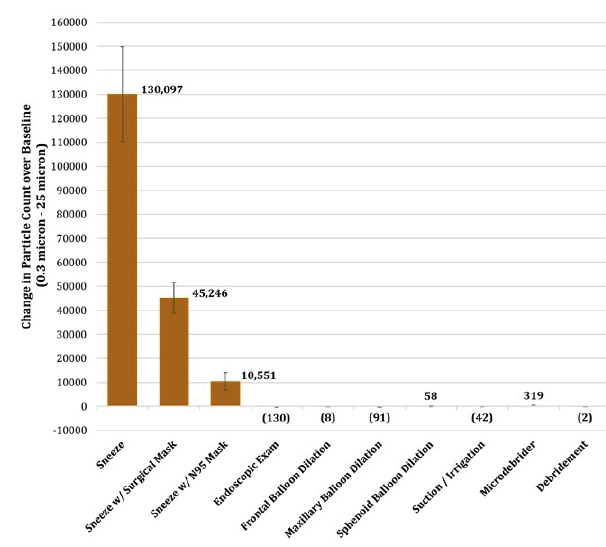
Figure 2. Particle count from common ENT office procedures. Mean change in particle count from baseline measurements for each proce- dure. Negative numbers are shown in brackets. Error bars represent the standard deviation for each